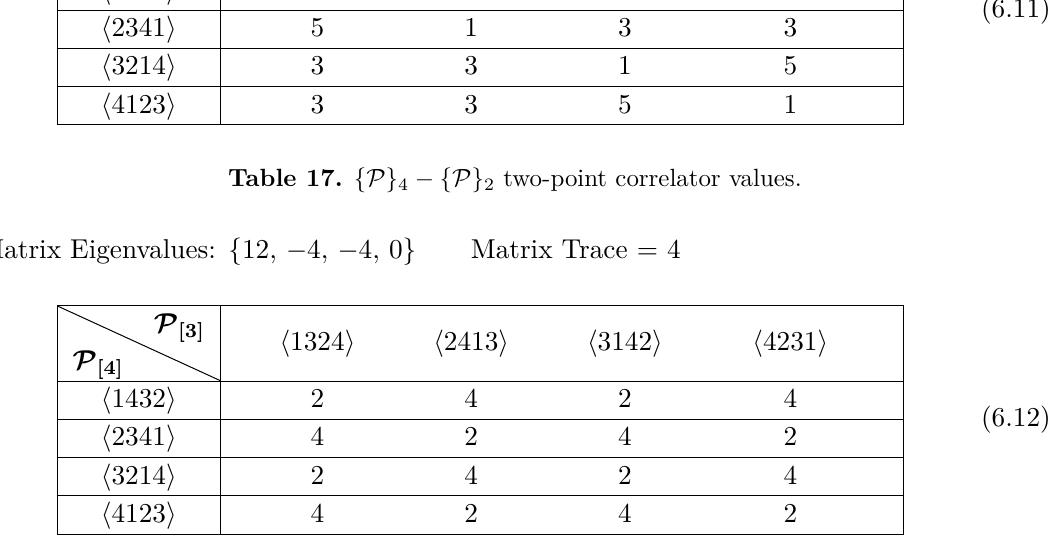
Table 18. {P} 4 − {P} 3 two-point correlator